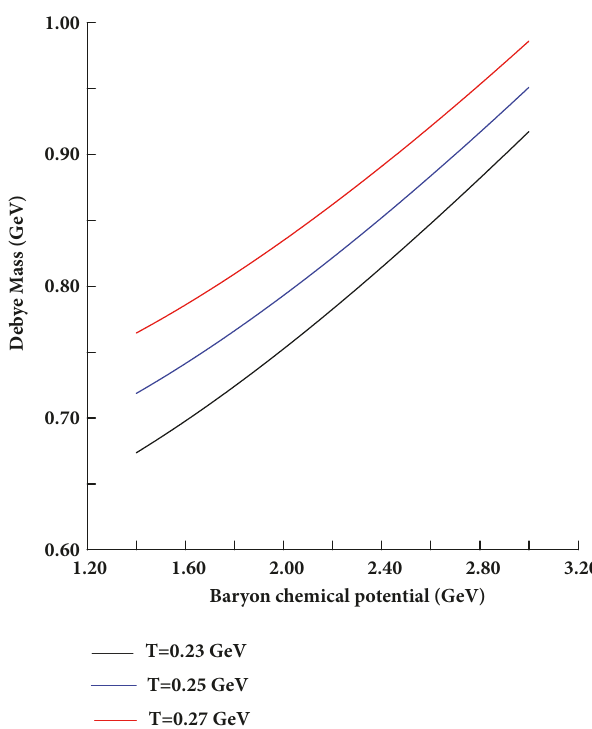
Figure 1: Debye mass is plotted as a function of baryonic chemical potential at different values of temperature.